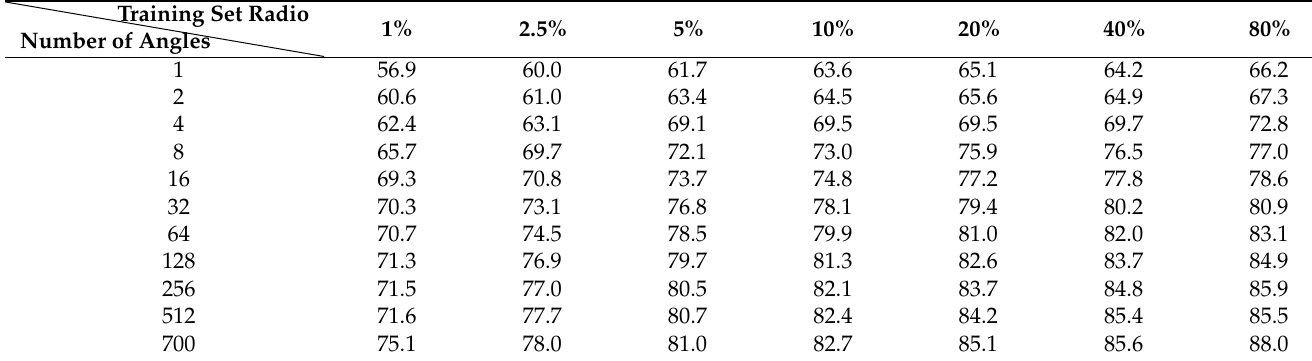
Table 2. Classification OAs derived using the SVM